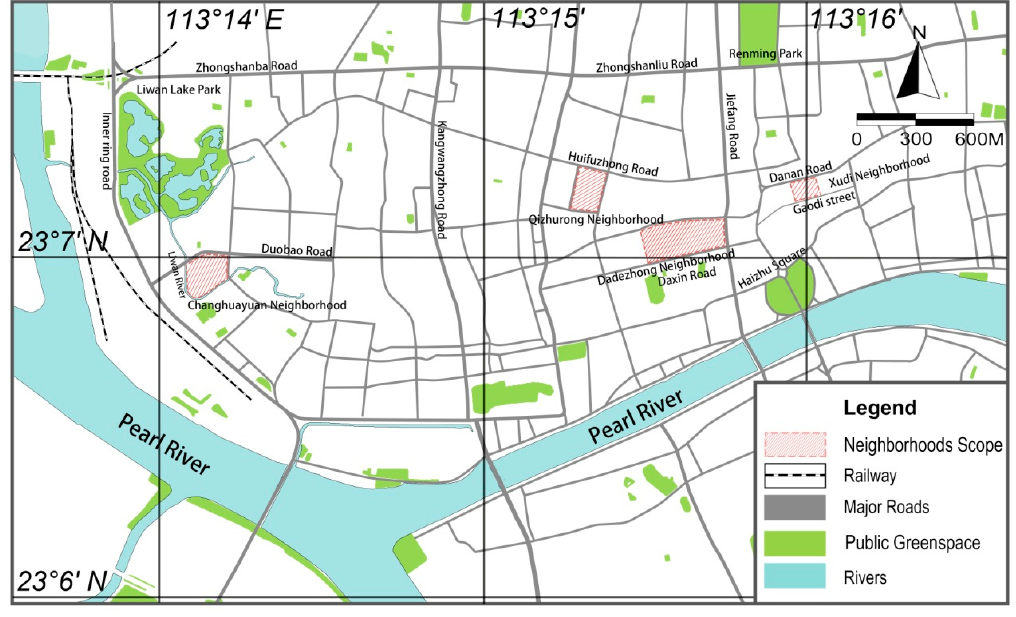
Table 1. Descriptive statistics for the environmental factors in the sample